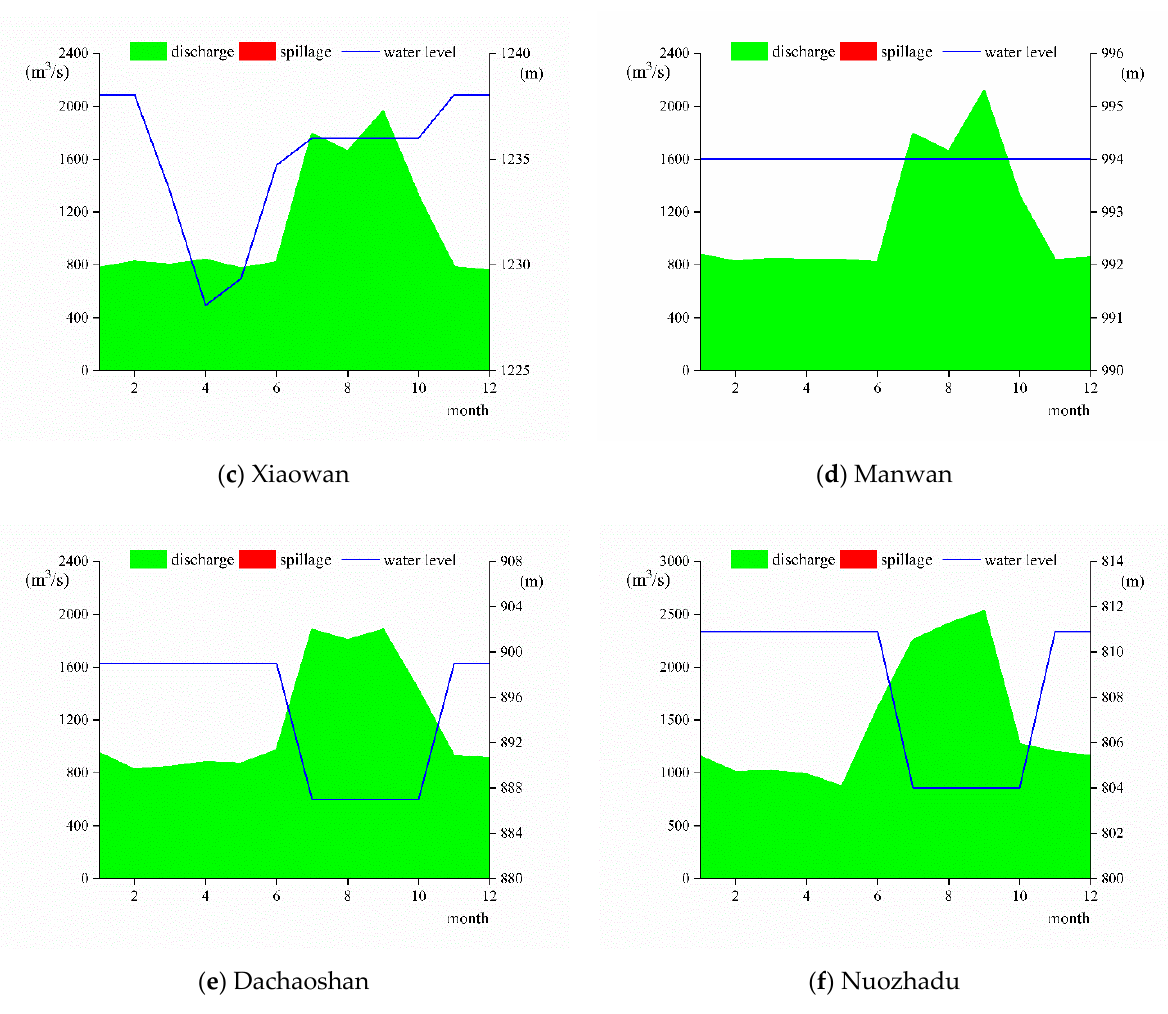
Figure 6. Monthly schedules over a year.